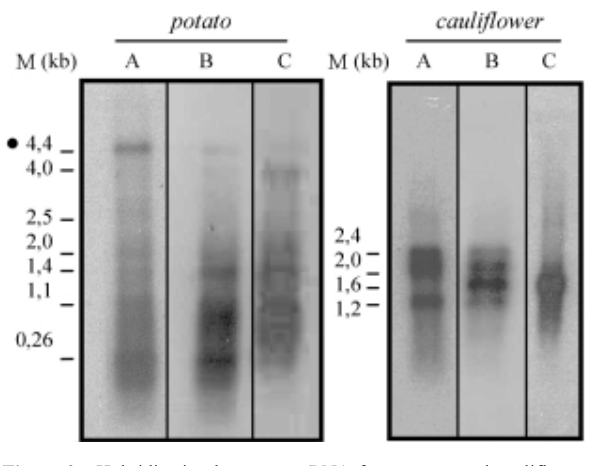
Figure 2 - Hybridization between mtRNA from potato and cauliflower with the following probes (indicated at the top of the pictures): A = sdh4 , B = sdh4/cox2 and C = cox2 . The numbers on the left of the pictures indi- cate the transcripts size in kb based on an Invitrogen 0.24 to 9.5 kb RNA Ladder molecular size marker (M). ((cid:127)) indicates the common transcripts for cox2 and sdh4 probes. The observed transcripts in the hybridization with the cox2/sdh4 probe correspond to the same transcripts observed in the separate hybridizations with sdh4 and cox2